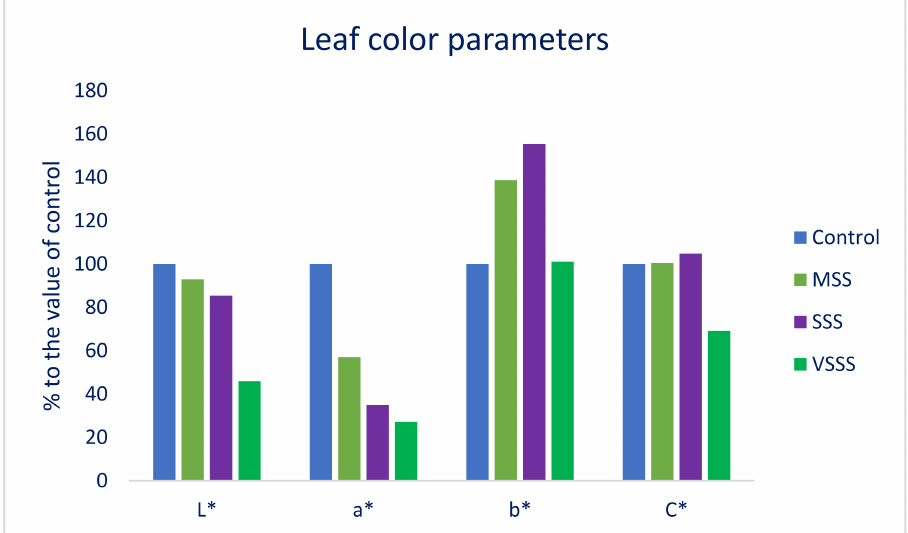
Figure 1. Changes in leaf color parameters (% to the value of control) under four salinity levels: Control (no saline water); MSS = medium salinity stress (50 mM NaCl); SSS = severe salinity stress (100 mM NaCl); and VSSS = very severe salinity stress (150 mM NaCl), in four selected A. lividus genotypes; L*, lightness; a*, redness/greenness; b*, yellowness/blueness; C* = chroma (leaf color intensity); ( n =